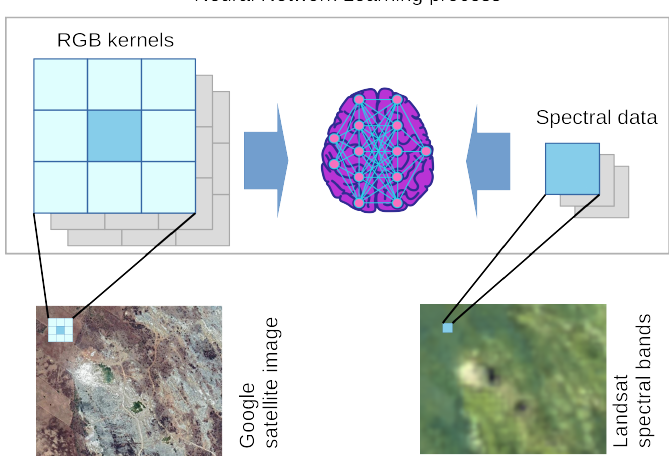
Figure 1. Kernel extraction and the neural network learning process. In this method, the RGB kernel (input) 3 × 3 × 3 is used to generate/predict 1 × 3 spectral bands (desired